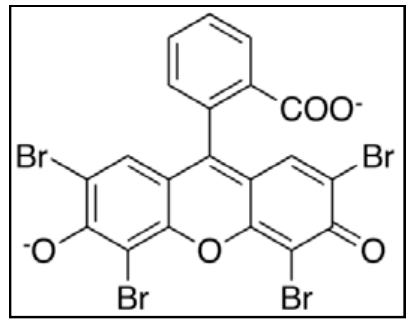
Fig. 1: Structure of Eosin Yellow IUPAC NAME: 2-(2,4,5,7-Tetrabromo-6-oxido-3-oxo- 3 H